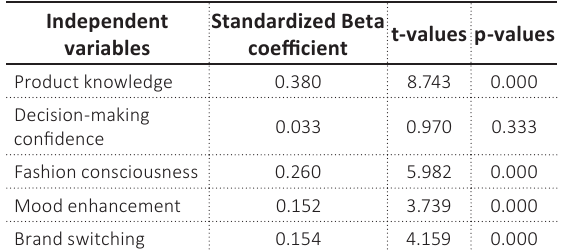
Table 5. Contribution of independent variables to predicting male Generation Y students’ fashion leadership